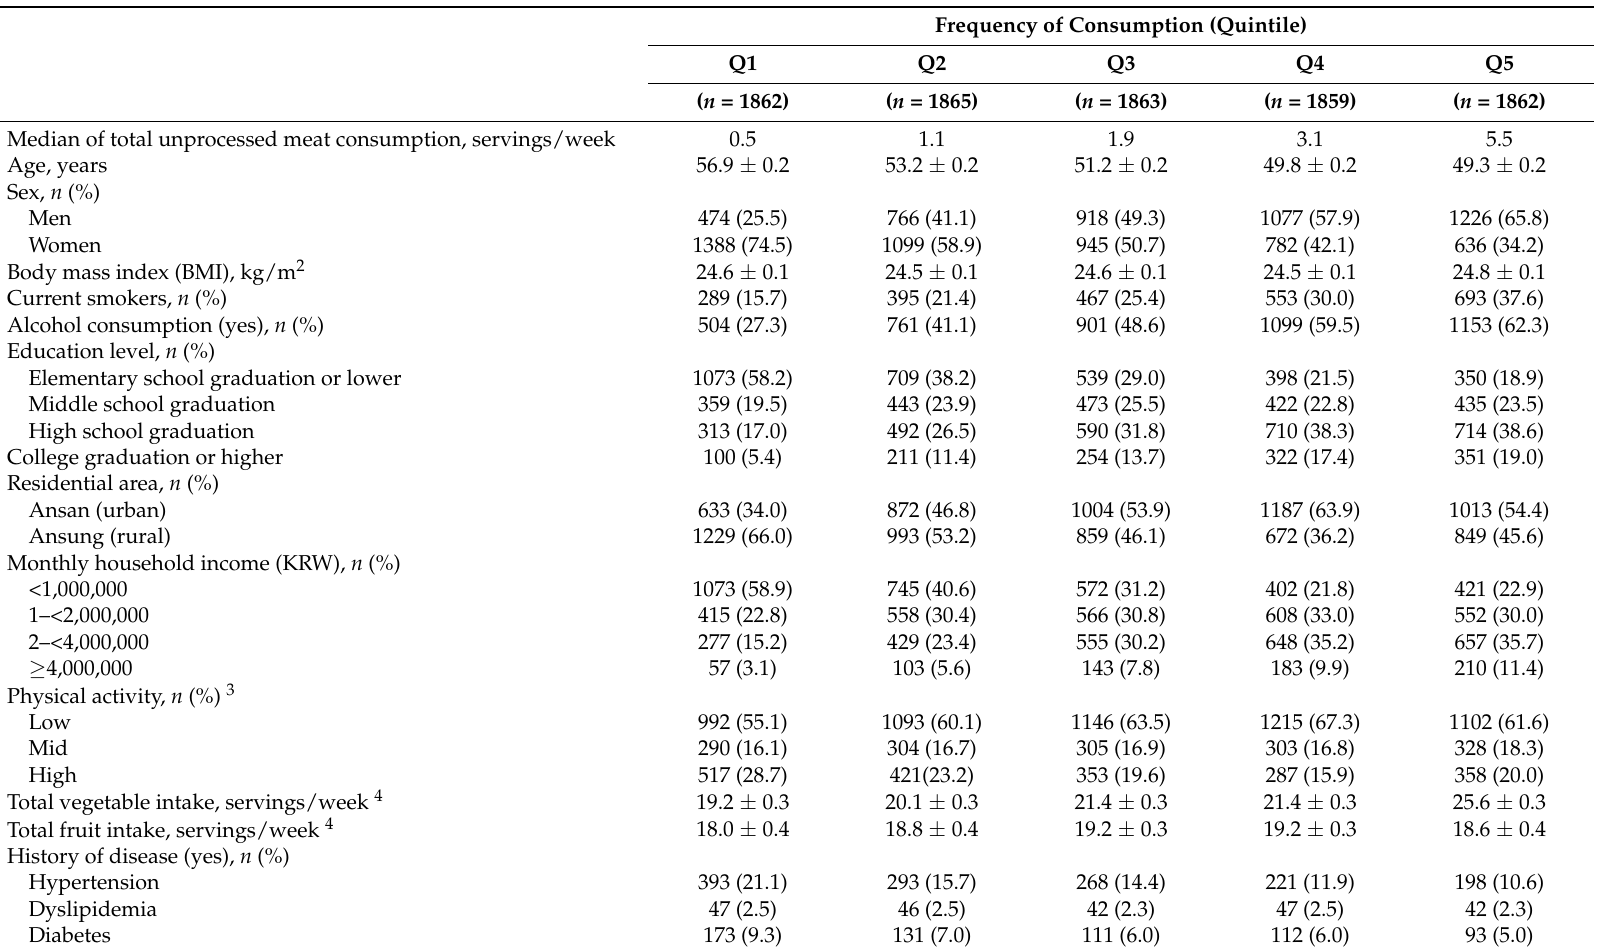
Table 1. Demographic and lifestyle characteristics of study participants according to quintiles of total unprocessed meat consumption in Korean adults 1